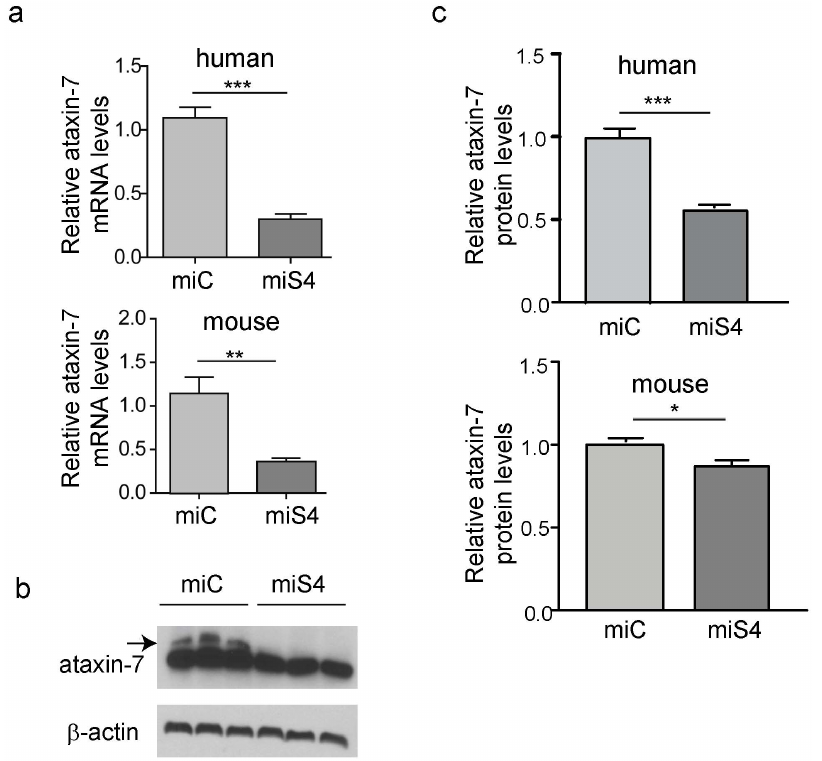
Figure 1. Reduction of ataxin-7 mRNA in the SCA7 mouse retina. (a) Relative levels of human (top panel) or mouse (bottom panel) ataxin-7 mRNA levels one month post-injection with AAV2/1 miC or miS4. (b) Representative western blot demonstrating mutant human (upper band, denoted by arrow) and mouse ataxin-7 (lower band) protein levels one month post injection of AAV2/1 miC or miS4. For quantification (c), ataxin-7 protein levels were normalized to b -actin (upper panel, human protein; lower panel, mouse protein). For all panels, results are represented as mean 6 SEM (n=3), ***p , 0.001, **P , 0.01,*p , 0.05.